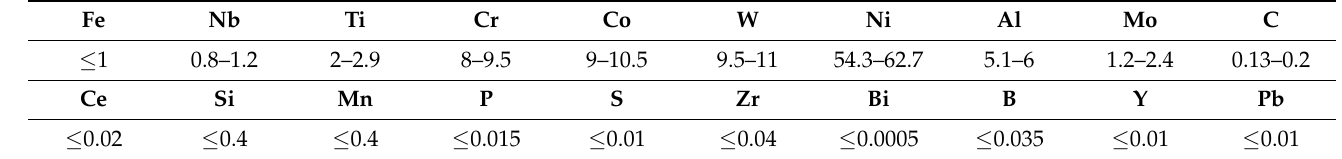
Table 1. Element composition of ZhS6U superalloy (wt%).